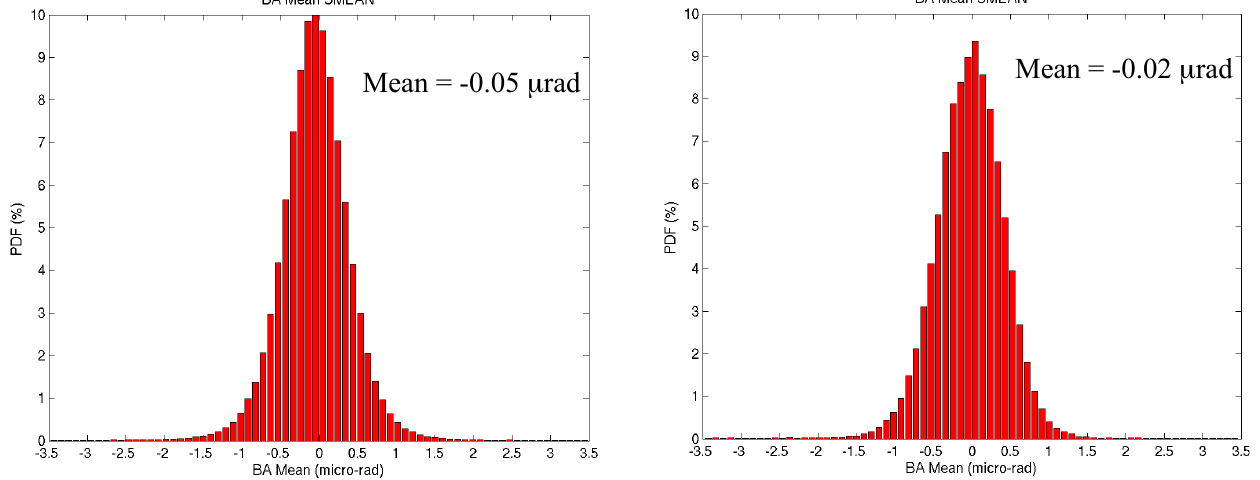
Fig. 17. Distribution of mean bending angle differences (from cli- matology) between 60 and 80km heights for ∼ 308000 F3C profiles from July–December 2009.